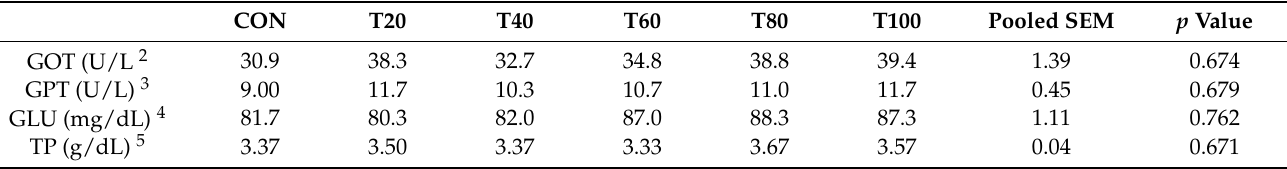
Table 6. Hematologic analysis of juvenile rainbow trout fed experimental diets for 8 weeks 1